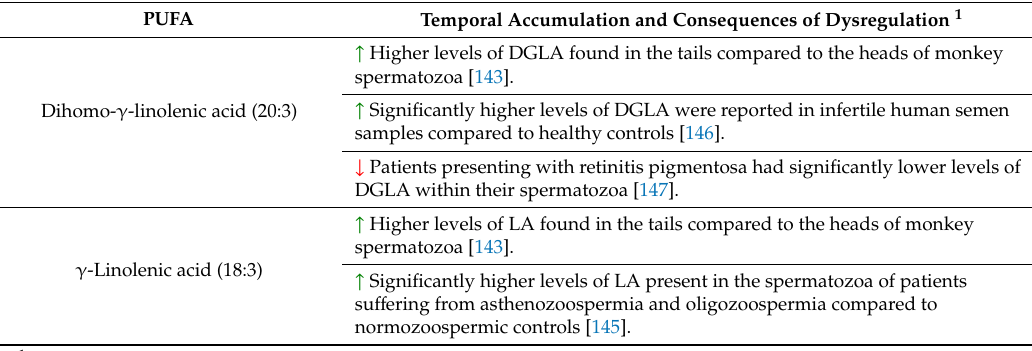
PUFA Temporal Accumulation and Consequences of Dysregulation 1